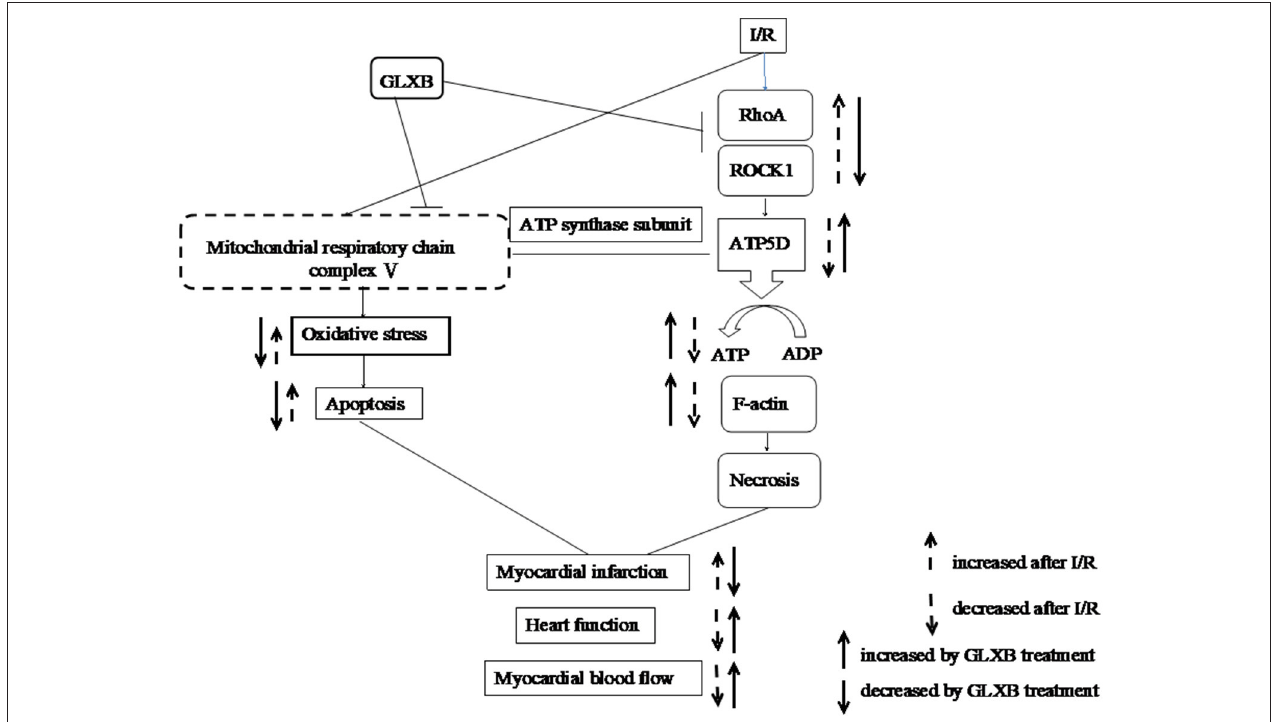
FIGURE 11 | A schematic showing the effect and signaling of GLXB on myocardial I/R injury. I/R activates RhoA/ROCK1 signaling that downregulates the expression of ATP 5D, leading to a decrease of ATP production, disintegrating of F-actin and cardiomyocyte necrosis. which contribute to the decrease in myocardial blood flow, myocardium infarct, and heart dysfunction. In addition, ischemia causes lack of oxygen and glucose which exaggerate the dysfunction of mitochondria respiratory chain, leading to oxidative stress and apoptosis, contributing to myocardium infarct, and heart dysfunction. GLXB inhibits RhoA/ROCK1 signaling, attenuates mitochondria dysfunction, thus improves the outcome of animals exposed to